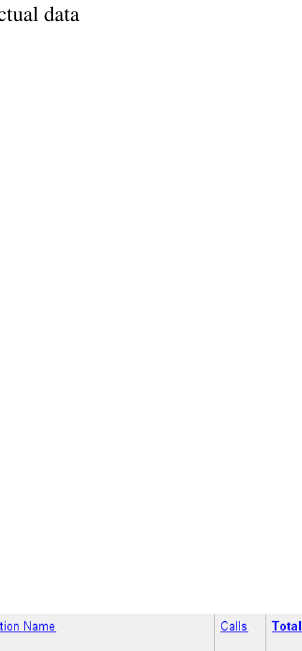
Fig. 6 Calculating results between the new method and the actual data